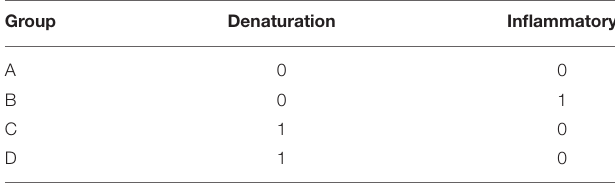
TABLE 4 | Grading of histopathological in the livers of